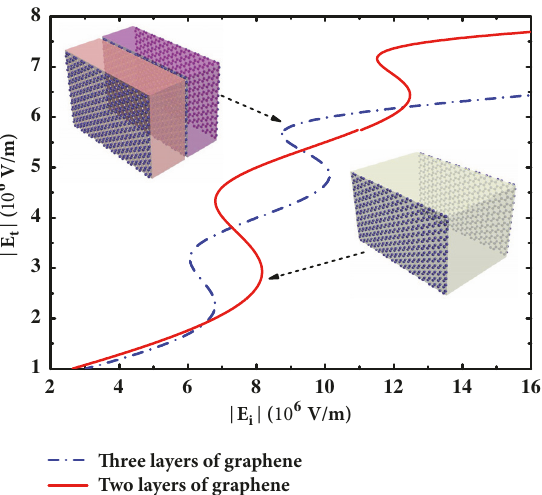
Figure 5: Optical tristability diagram of the system with two layers of graphene (red solid lines) and three layers of graphene (blue-